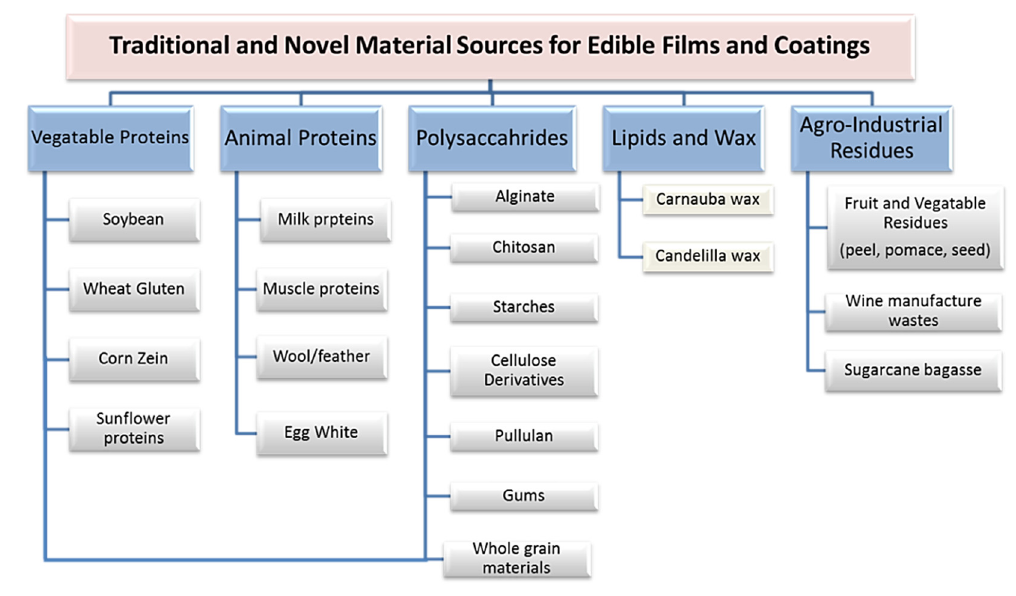
Figure 1. Classification of edible coating and film sources.